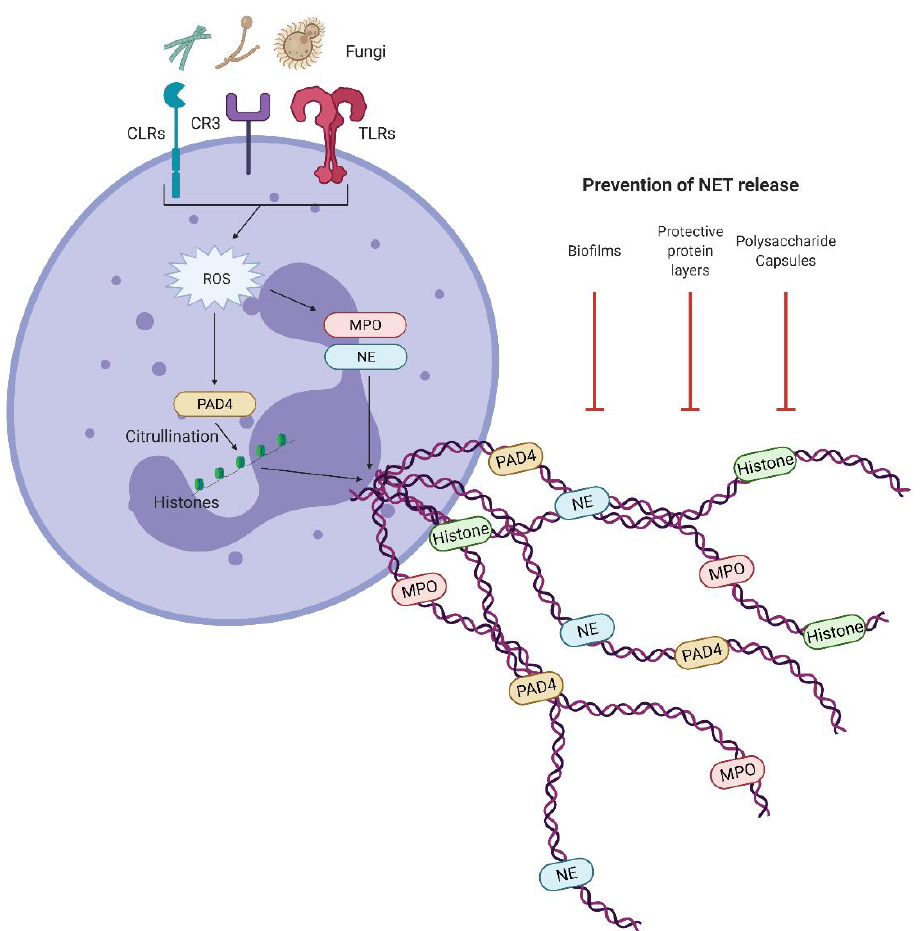
Figure 4. Fungal induction of NETs. Neutrophil extracellular traps (NET) are canonically formed when reactive-oxygen species (ROS) production leads to protein arginine deiminase 4 (PAD4)-dependent citrullination of histones, after which chromatin decondensation occurs and NETs are released upon cell rupture, resulting in cell death. Fungi activate a number of neutrophil receptors, including C-type lectin receptors (CLR), toll-like receptors (TLR), and complement receptor (CR)-3, to induce NETosis. NET release can occur via both ROS- and/or PAD4-dependent or -independent mechanisms. Released NETs can contain myeloperoxidase (MPO), neutrophil elastase (NE), histones, and calprotectin, and aid in antifungal activity. Fungi possess a number of features that prevent the generation of NETs including protective outer layers ( A. fumigatus hydrophobin layer and C. neoformans polysaccharide capsule) or the ability to form biofilms ( C. albicans ).